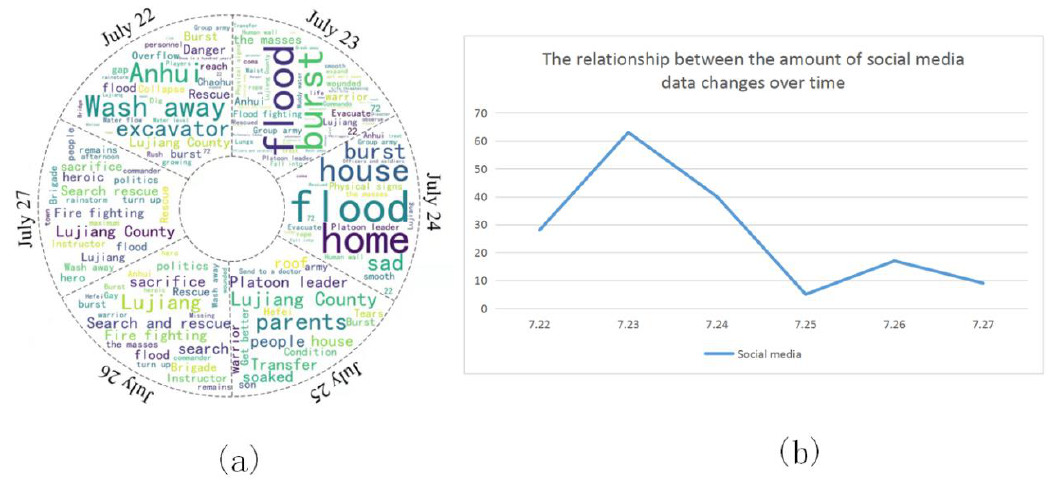
Figure 8. Monitoring the disaster in “Tongda Town” based on social media data. Among them, ( a ) depicts how the themes of social media data related to “Tongda Town” changed over time; ( b ) depicts how the amount of social media data related to “Tongda Town” changed over time.